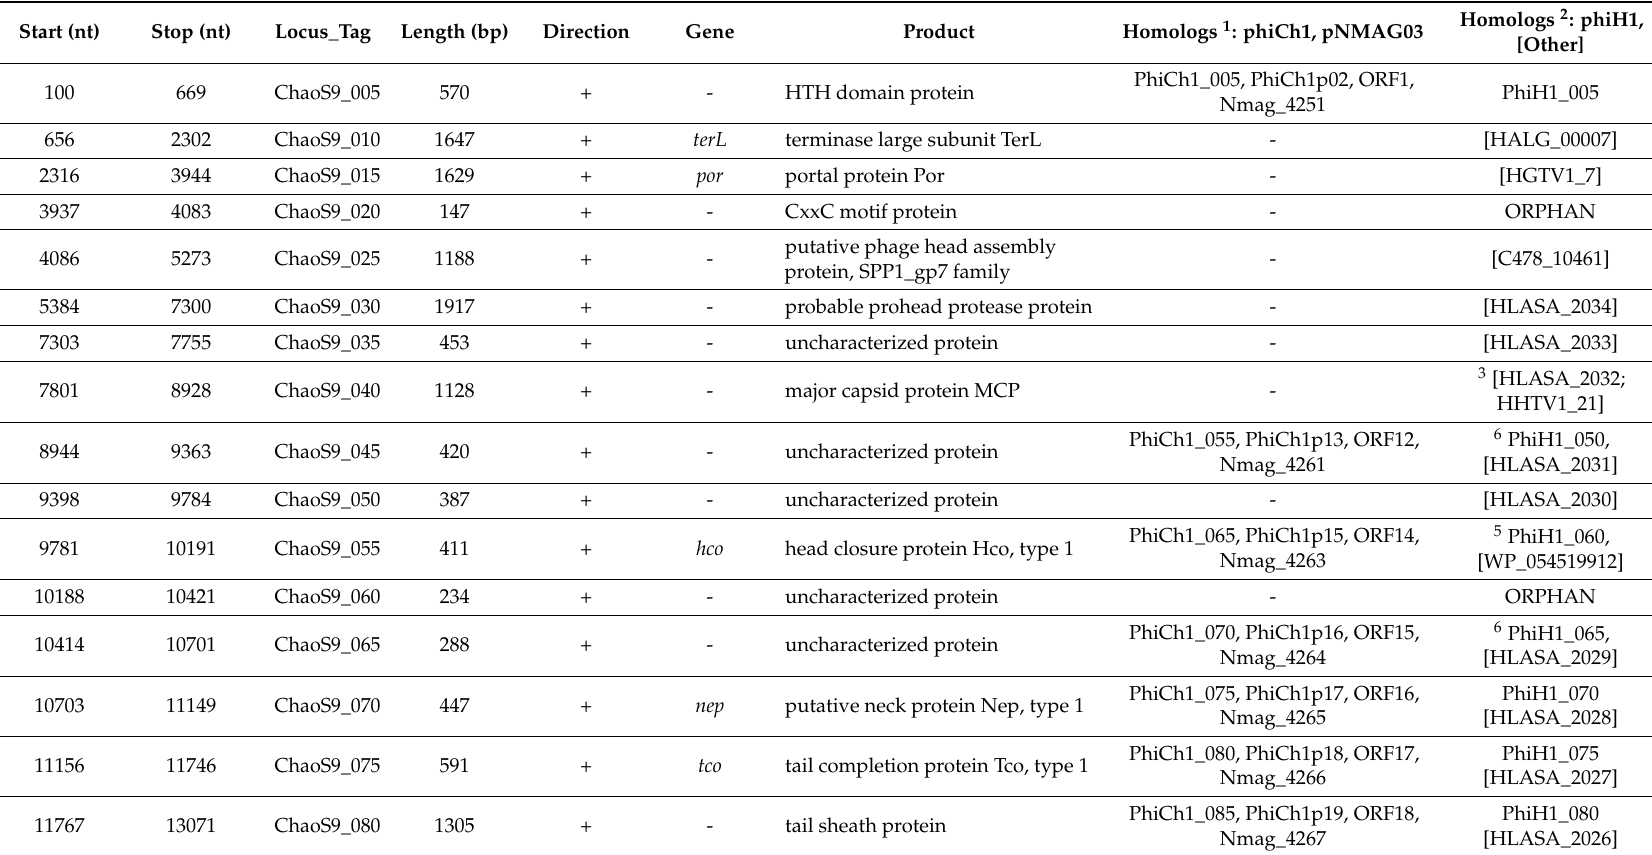
Table 2. Annotated coding sequences (CDS) of the ChaoS9 genome (accession